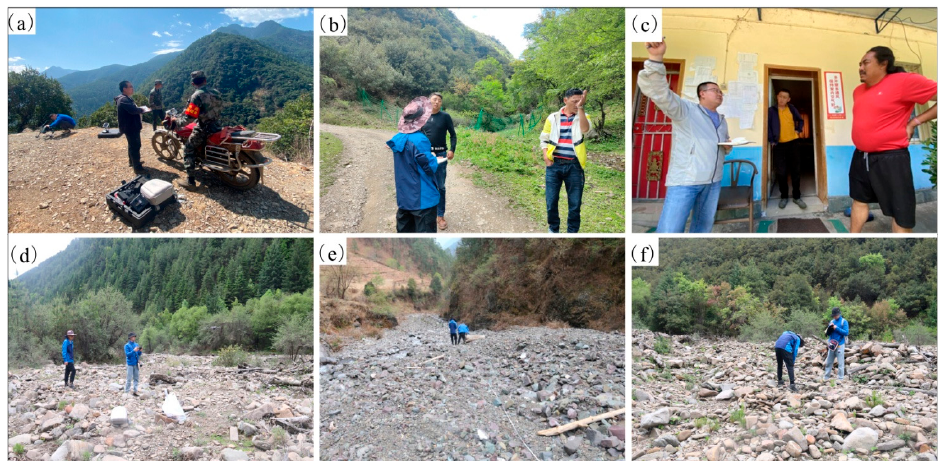
Figure 2. Field investigation of three typical debris flow gullies. ( a – c ) On-site survey and interviews in Yapi gully, Catuo gully, and Dakang gully. ( d ) UAV Flight in Dakang gully. ( e , f ) Field measurement of roundness in deposit fan.